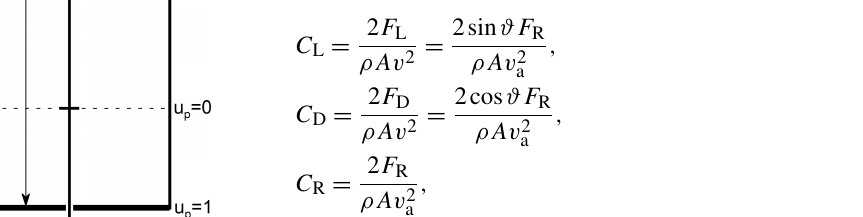
The dashed line in Fig. 2 defines the tensile axis of the airborne system, which in the case of a negligible effect of gravity is aligned with the resultant force F R and inclined to the horizontal plane by the elevation angle ϑ